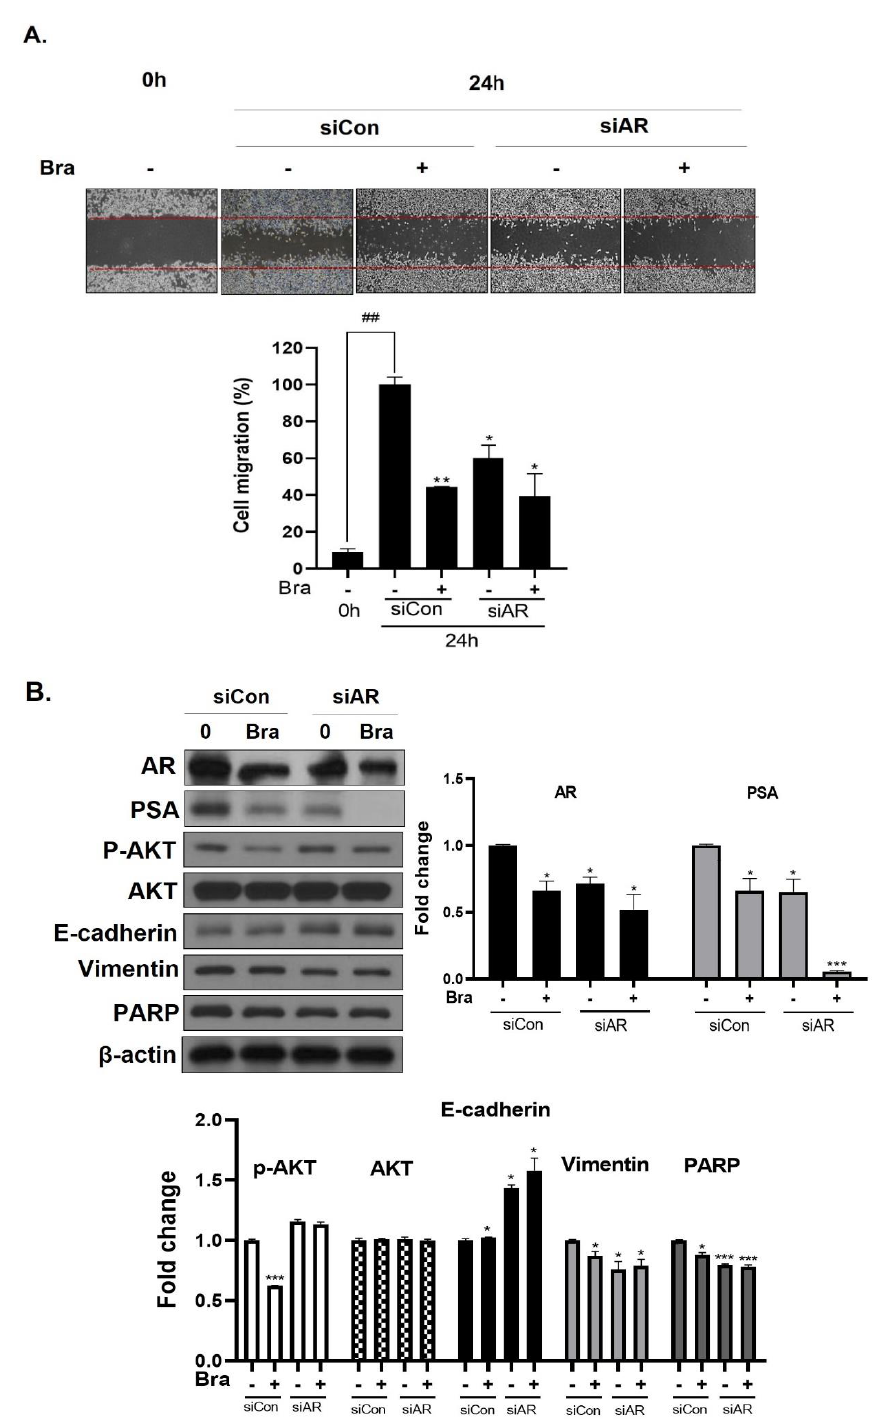
Figure 5. E ff ect of AR siRNA on cell migration, proliferation, and apoptosis-related markers in Brassicasterol treated LNCaP cells. LNCaP cells were transfected with AR siRNA for 24 h and were incubated in the presence or absence of brassicasterol (10 µ M) for 24 h. ( A ) A wound-healing assay assessed cell migration. Bar graph represents the quantification of cell migration, present as a percentage of control of siRNA. (*) p < 0.05, (**) p < 0.01 (in comparison to 24 h control of siRNA) (##) p < 0.01 (in comparison to 0h control). ( B ) The cell lysates were prepared and subjected to Western blotting to determine the expression of AR, PSA, p-AKT, AKT, E-cadherin, vimentin, PARP, and β -actin. Bar graphs represent the quantification of interest protein related to β -actin, present as a fold change of control of siRNA. (*) p < 0.05, (***) p < 0.01 (in comparison to